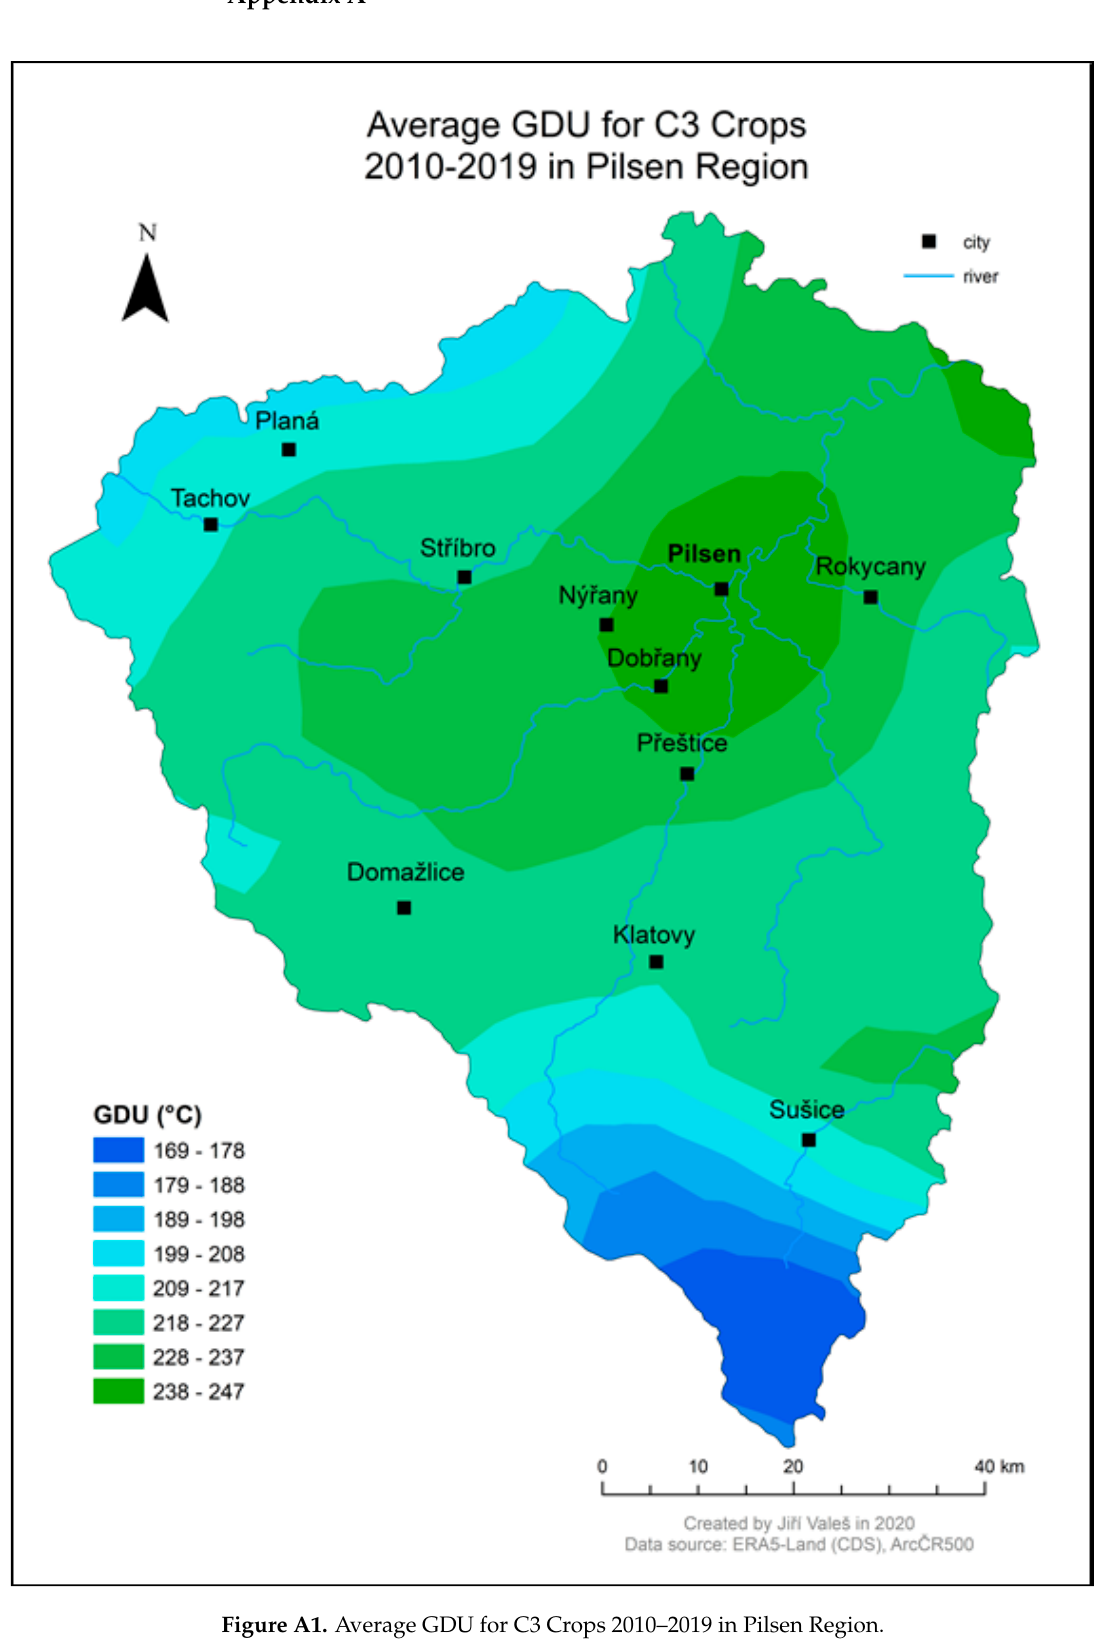
Figure A1. Average GDU for C3 Crops 2010–2019 in Pilsen Region.